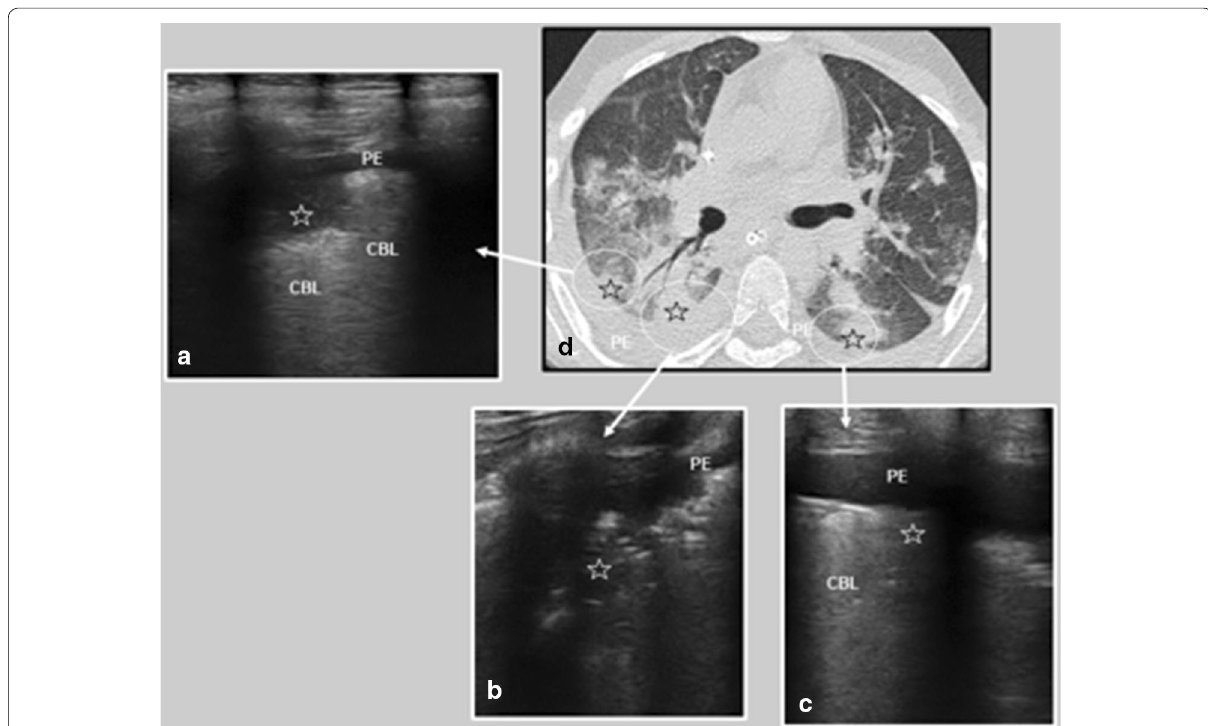
Fig. 1 Eleven‑year‑old male with respiratory failure and shock. Lung US ( a – c ) was performed on the 5th day after symptom onset and chest CT ( d ) on the 15th day. There was a pleural effusion (PE in a – d ) and subpleural consolidations (stars in a – d ). Confluent B‑lines (CBL in a and c ) were also present in the lung US, corresponding to the chest CT ground‑glass pattern